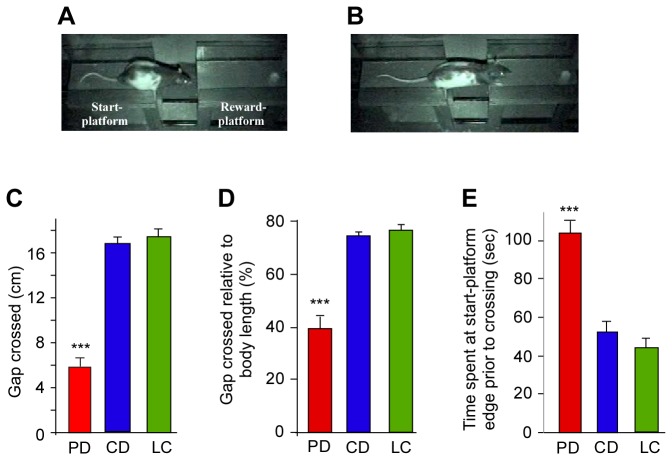
Performance on the GC task by PD and control rats.
A, B, Video frames of a control rat contacting the reward-platform with its whiskers (A) and crossing the gap (B). C, Width of gap crossed by PD, CD and LC rats. D, Gap crossed by PD, CD and LC rats normalized to the body-length to control for differences in size. E, Time spent by PD, CD and LC rats at the start-platform prior to performing the final successful jump. The differences between CD and LC controls were not significant. *** p ≤ 0.001. PD: protein-deficient diet fed rats, CD: control diet fed rats; LC: laboratory chow fed rats.